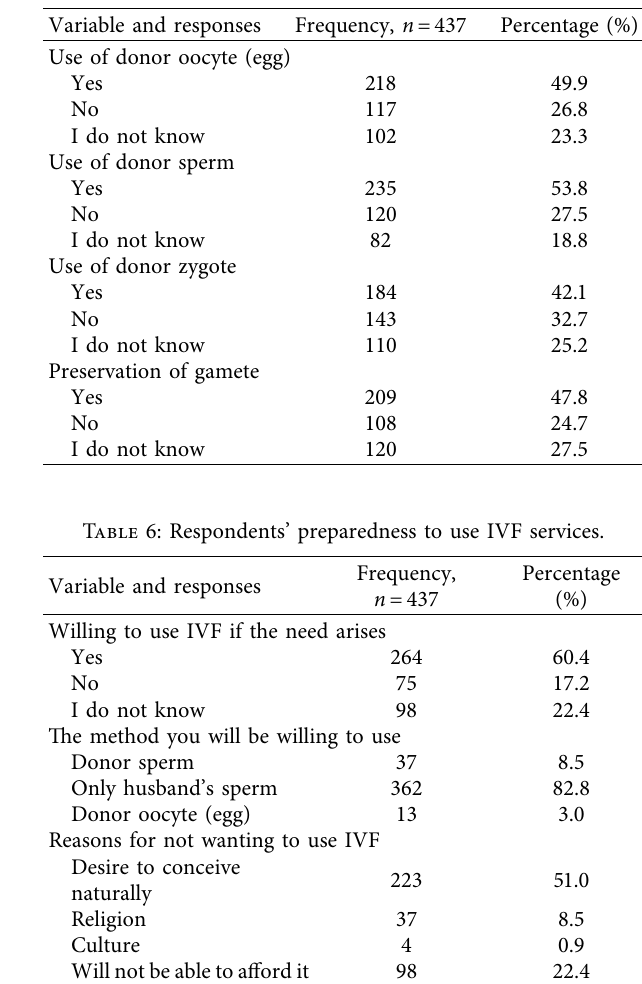
Table 3: Respondents’ level of qwareness of IVF services.